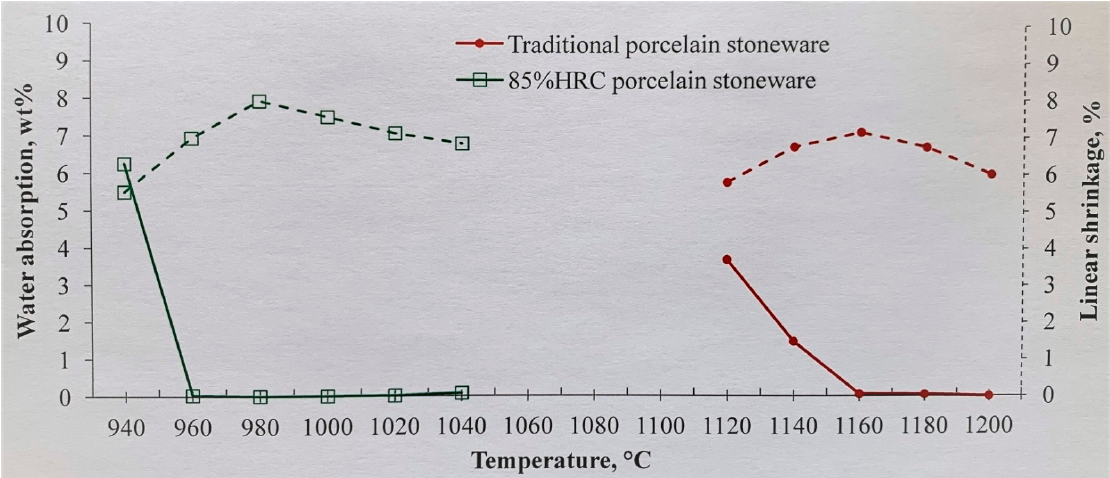
Figure 4. Water absorption (solid lines) and linear shrinkage (dashed lines) of 85% HRC and traditional porcelain stoneware